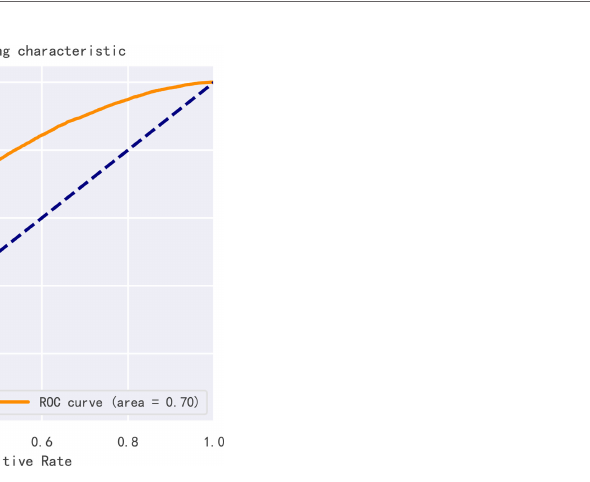
FIGURE 6 | Receiver operating characteristic curve (ROC) of the model. Receiver operating characteristic curve (ROC) of the